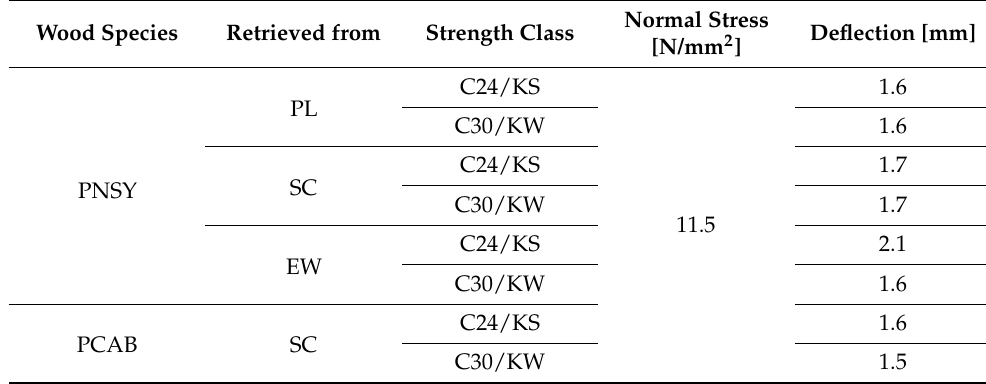
Table 9. Normal stresses and deflection (displacement) of E version short frames made of glued material with a finger-jointed lamella length of 200